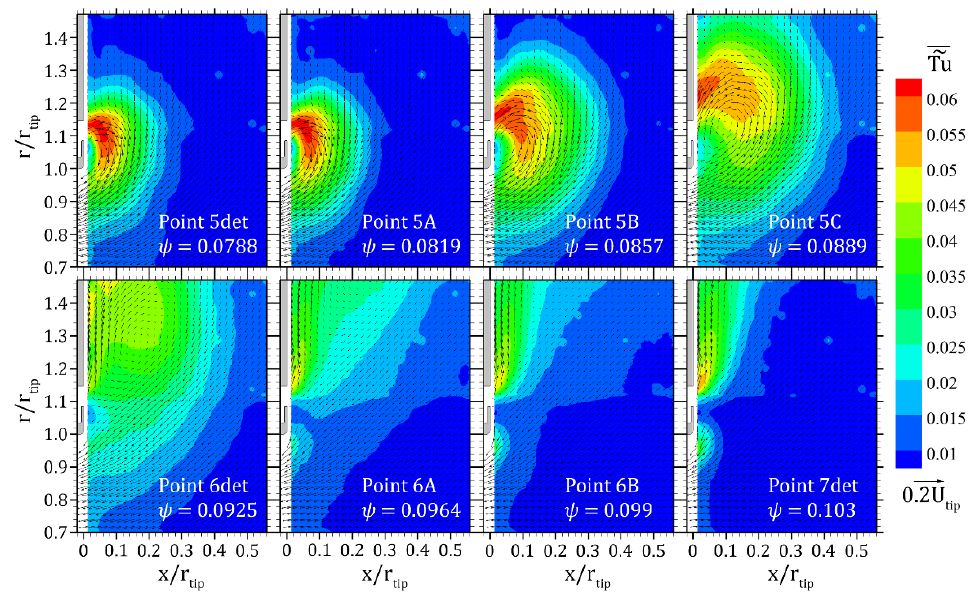
Figure 4. Time averaged flow field in the gap region: detailed survey.